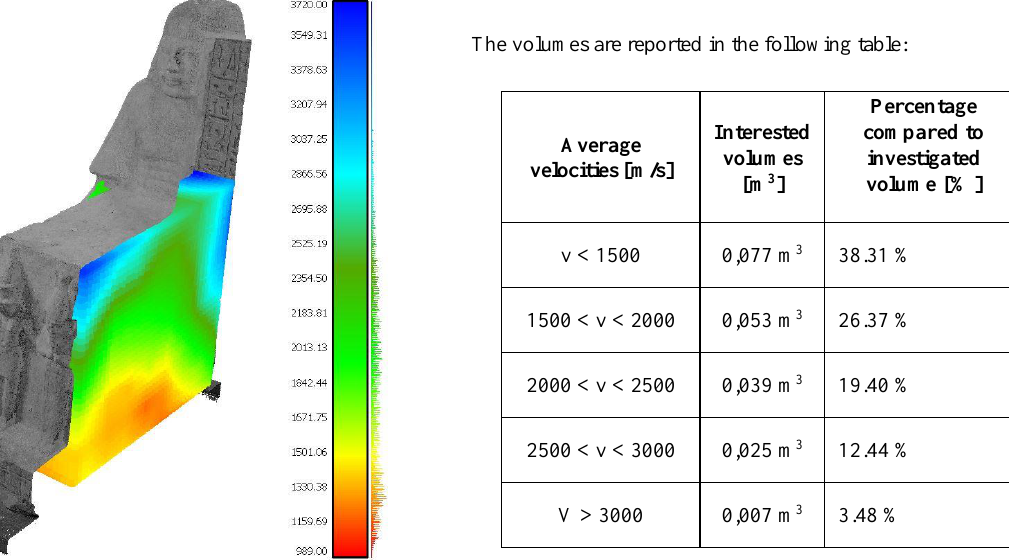
Figure 16. The closed meshes extracted from the classified point cloud.